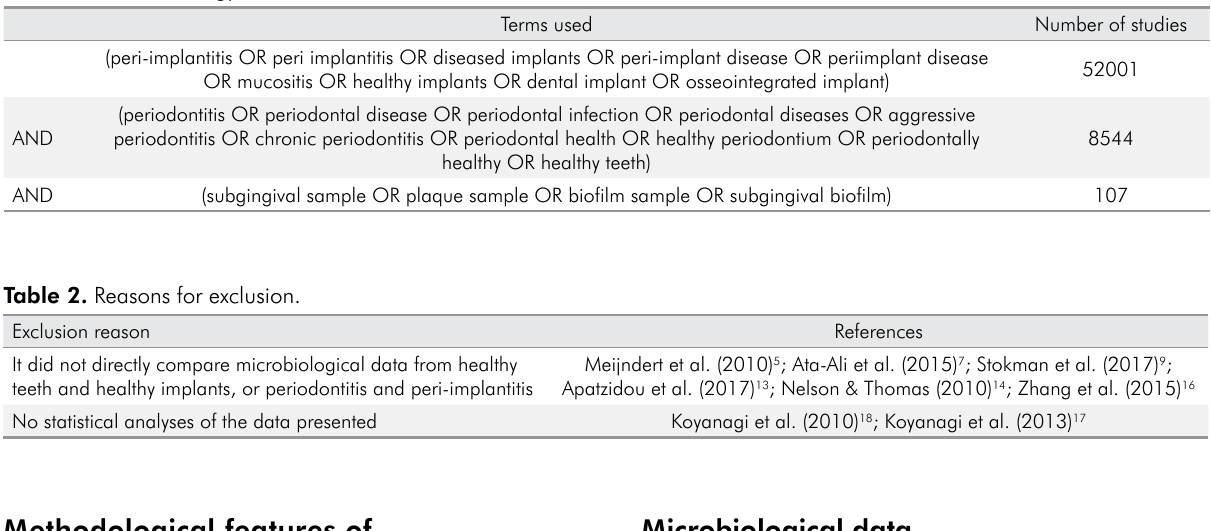
Table 1. Search strategy.